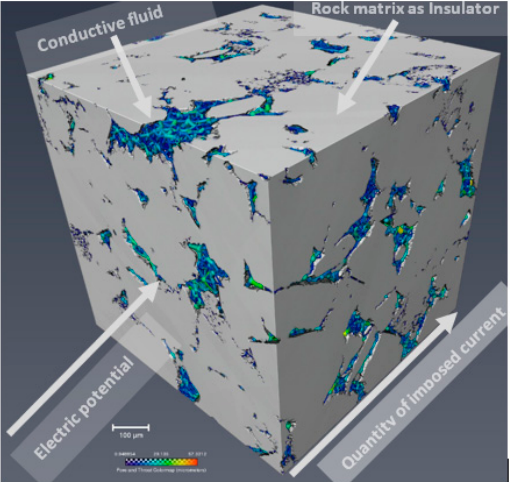
Figure 1. A 3D view of a rock showing the boundary conditions and components of the electrical